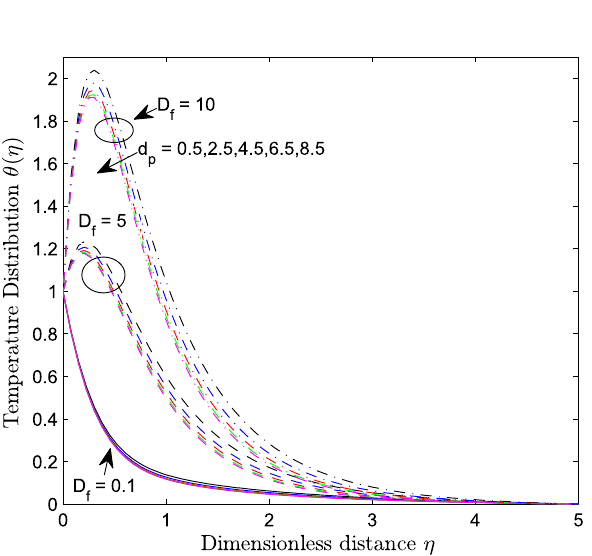
direction with d p at various values of d f . −